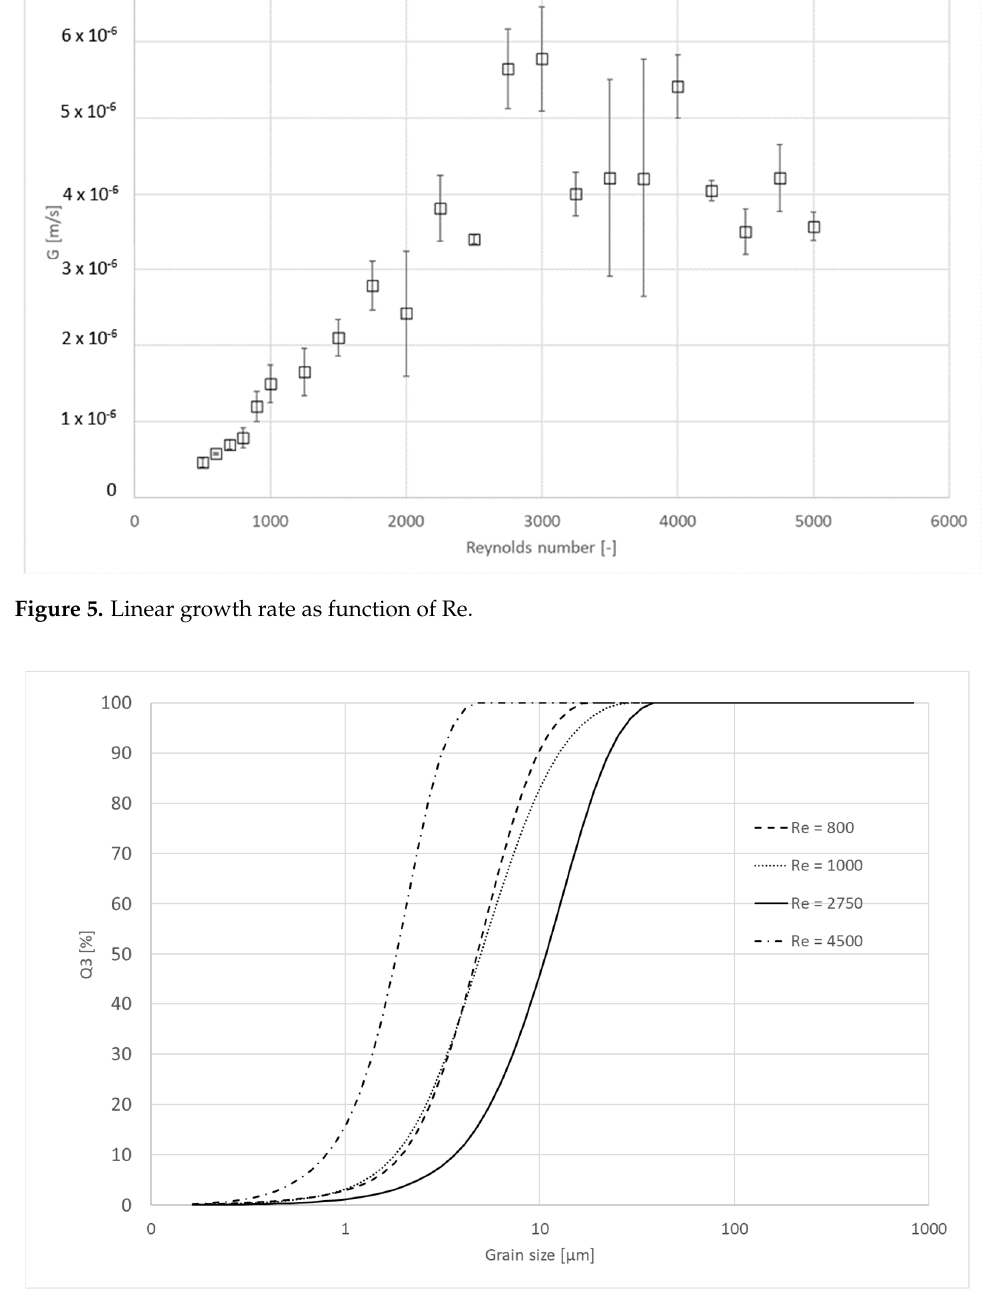
Figure 6. Percentage of subgrain distribution for Re = 800, Re = 1000, Re = 2750 and Re = 4500.